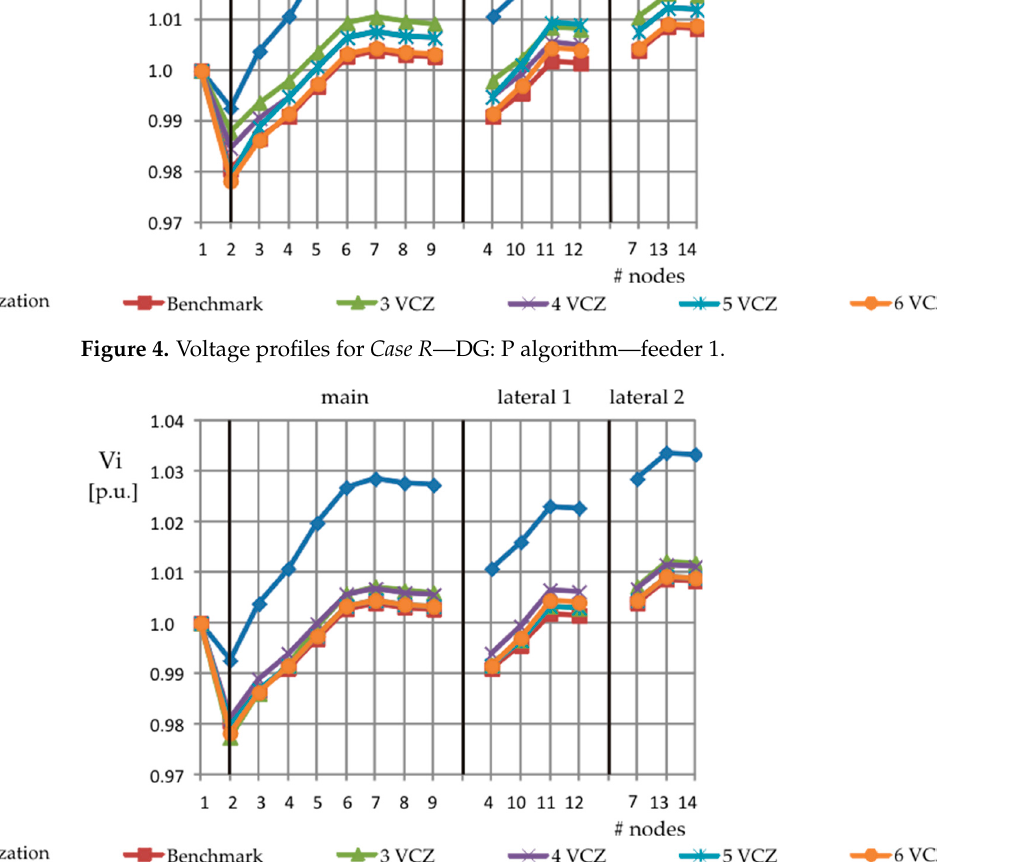
Figure 5 : Voltage profiles for Case R — DG: Q algorithm—feeder 1.